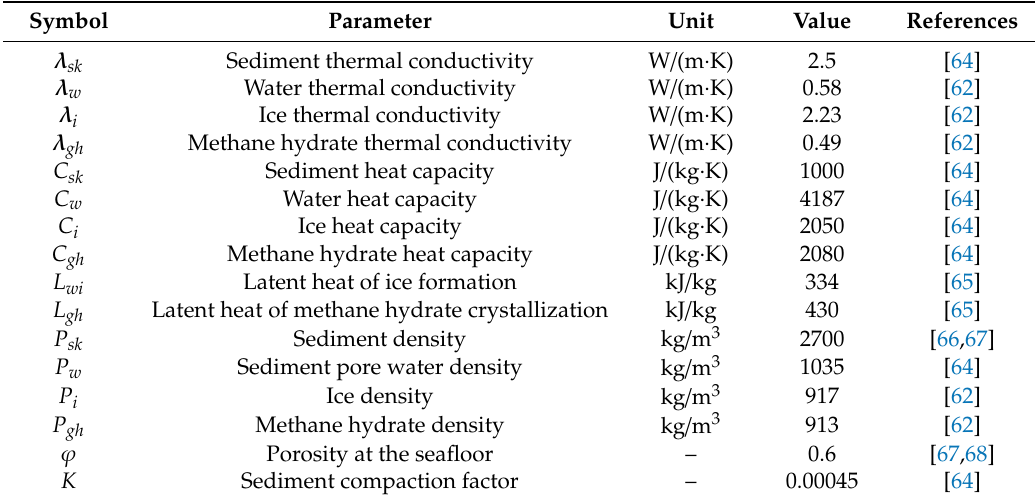
Table 2. Key model parameters of the relic subsea permafrost (RSP) and GHSZ